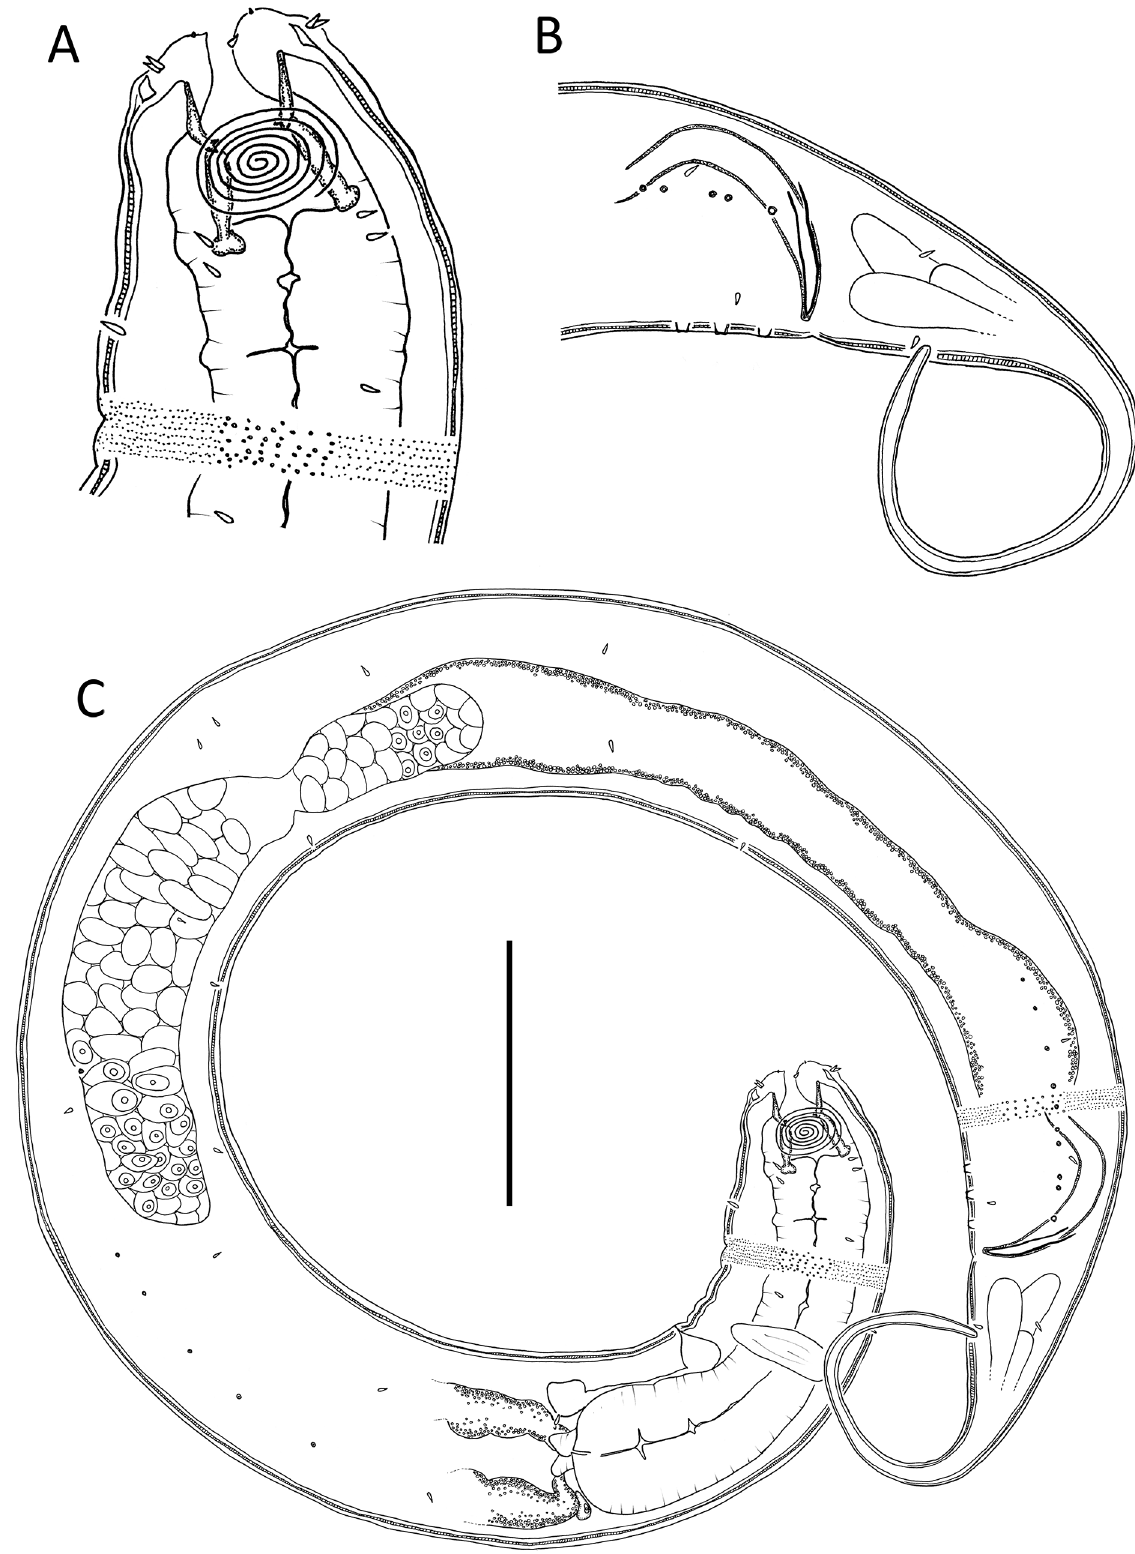
Fig. 10. Halichoanolaimus pumilus sp. nov. Holotype ♂, NIWA 139250. A . Anterior body region. B . Posterior body region. C . Entire ♂. Scale bar: A = 25 µm; B = 42 µm; C = 60